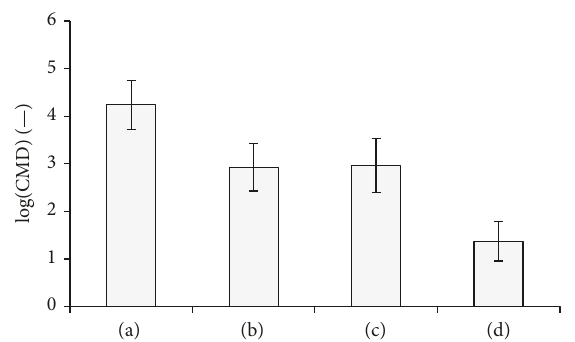
Figure 3: The homogeneity differences between injection molded test specimens: (a) original masterbatch, (b) modified masterbatch produced on a special extruder, (c) modified masterbatch pro- duced on the LabTech corotating twin-screw extruder, and (d) compounded material.